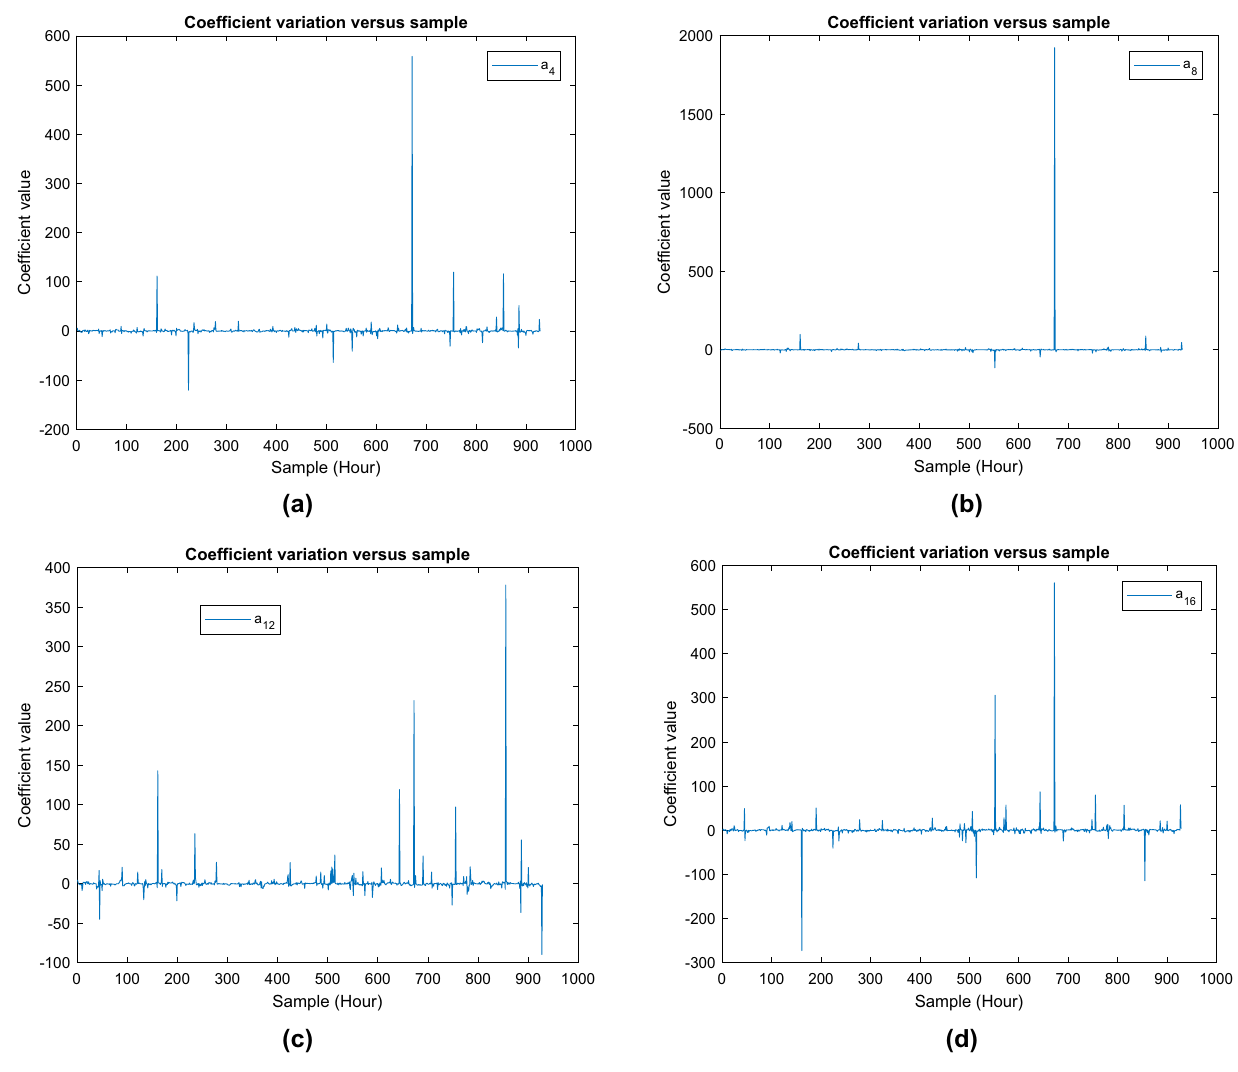
Fig. 11 Hourly variation of the 4th, 8th, 12th, and 16th coefficient for the AUD/CAD exchange rate signal